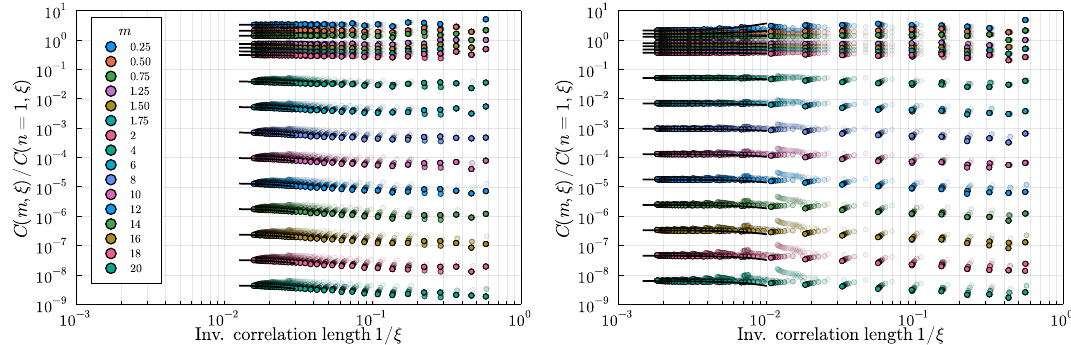
= 2 and χ = 6, for B B